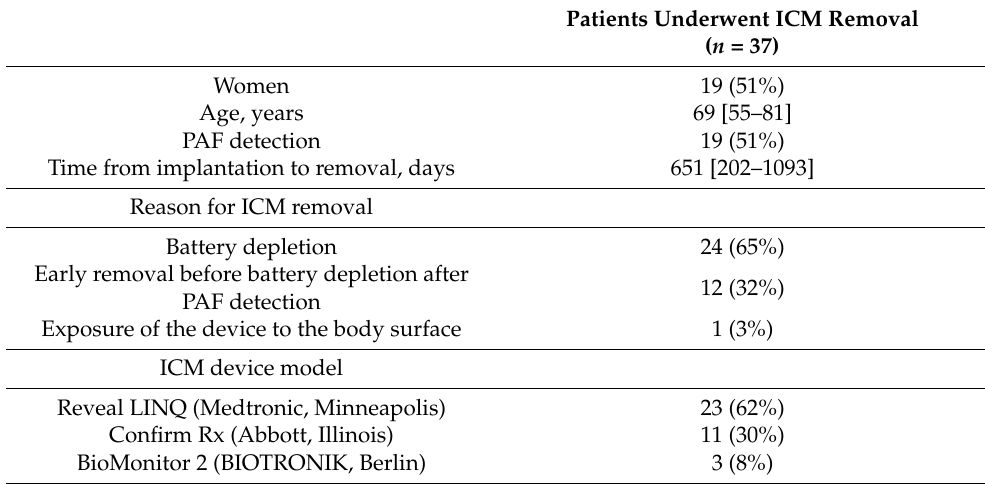
Table 1. Baseline characteristics of patients with cryptogenic stroke who underwent removal of the insertable cardiac